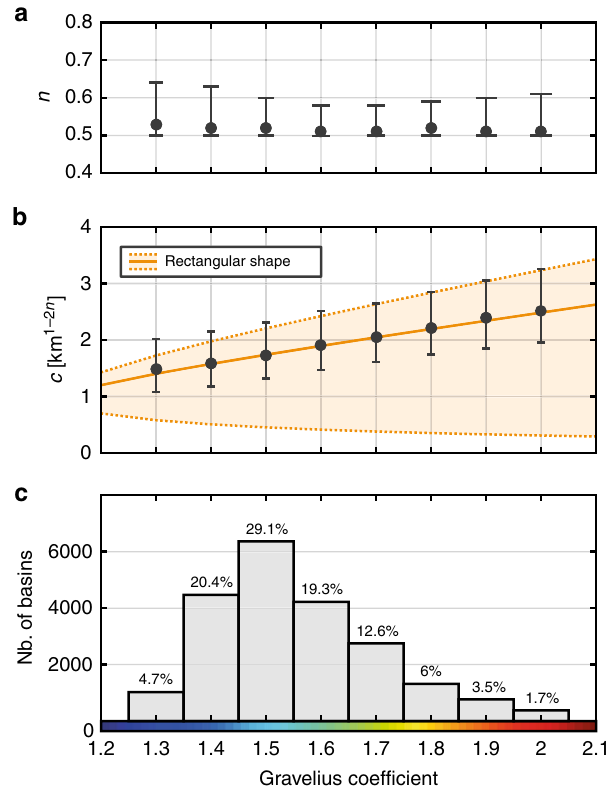
Fig. 5 Hack ’ s Law parameters vs. Gravelius compacity coef fi cient. a , b Exponent ( n ) and coef fi cient ( c ) for the eight interval classes of GC showed in Fig. 2. Error bars are de fi ned considering the 95% likelihood contour obtained for each class. Orange solid line corresponds to the relation obtained from Eq. (4). Orange dotted lines represent the lower and upper bounds for the Hack ’ s coef fi cient assuming a simple rectangular basin. c Number of basins for each class of GC and its associated proportion within the